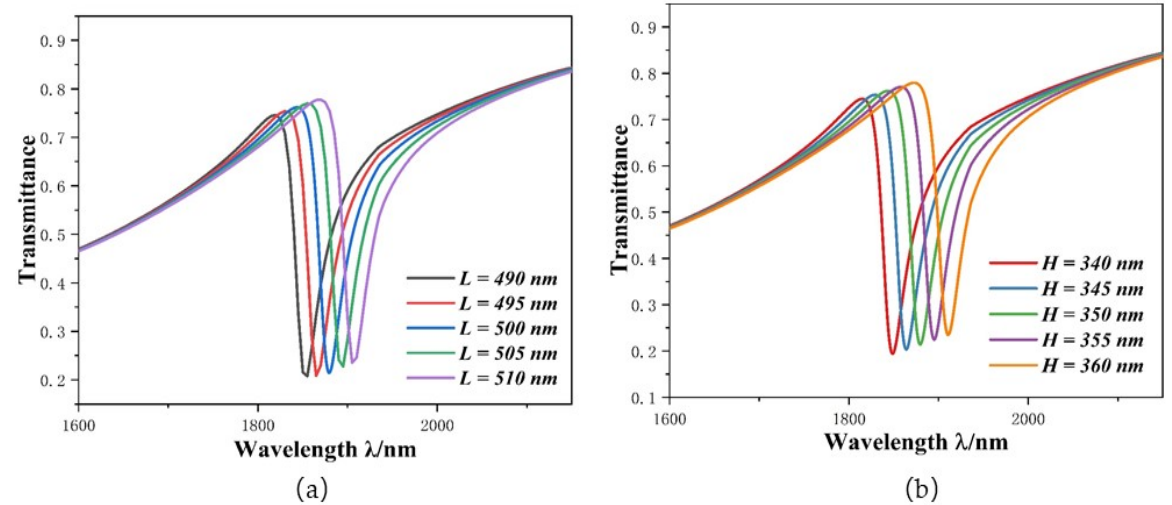
Figure 9. ( a ) Transmission spectra of L ; ( b ) Transmission spectra of H .